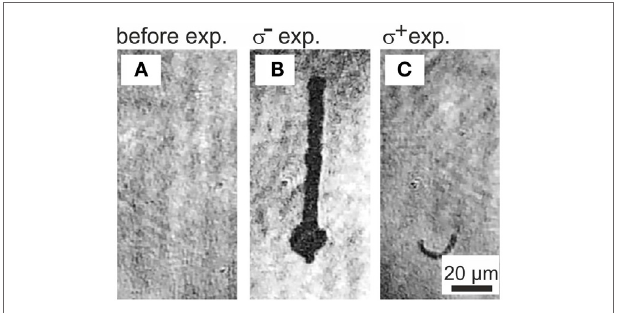
FigUre 6 | all-optical helicity dependent magnetic switching in a 19-nm-thick Tb 30 Fe 70 film . (a) Faraday image of the homogeneously magnetized film before laser irradiation. (B) Faraday image showing a written stripe domain after interaction with right-handed circularly polarized laser light. (c) Erased stripe with left-handed circularly polarized laser light using the same fluence as in (B)